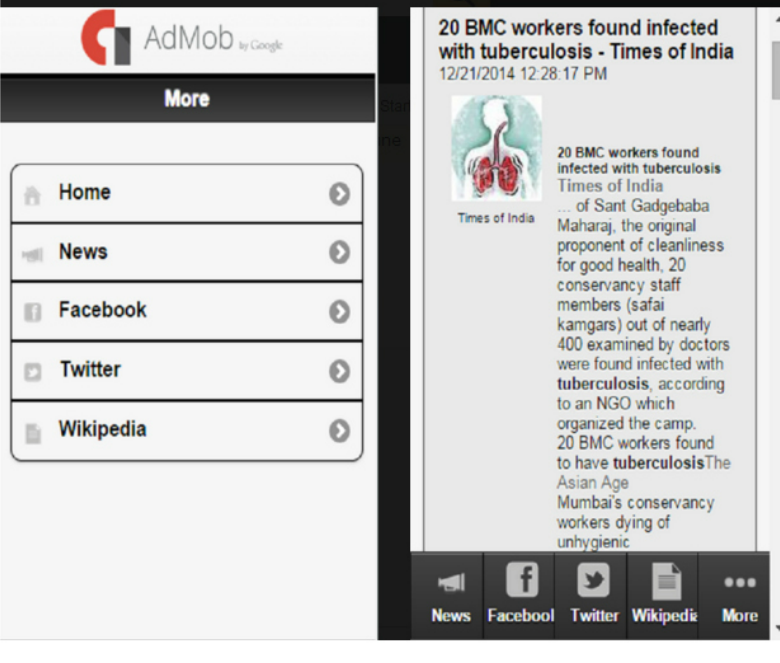
Figure 3. Explain